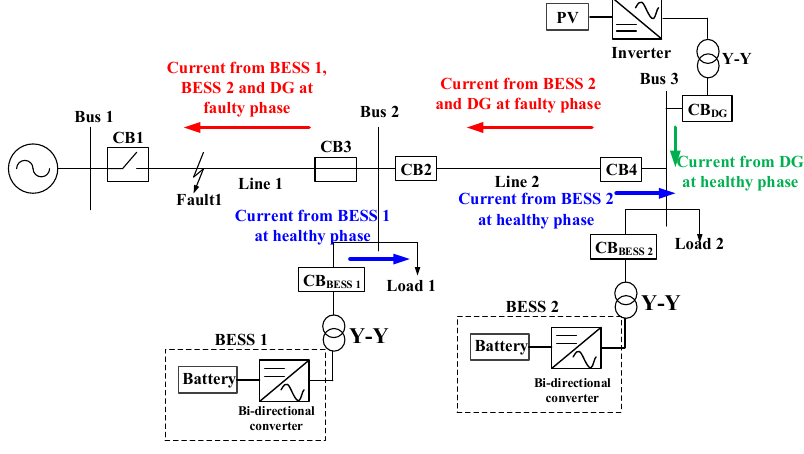
Figure 6. Current flow after the reclosing of CB3 when the fault is not removed.